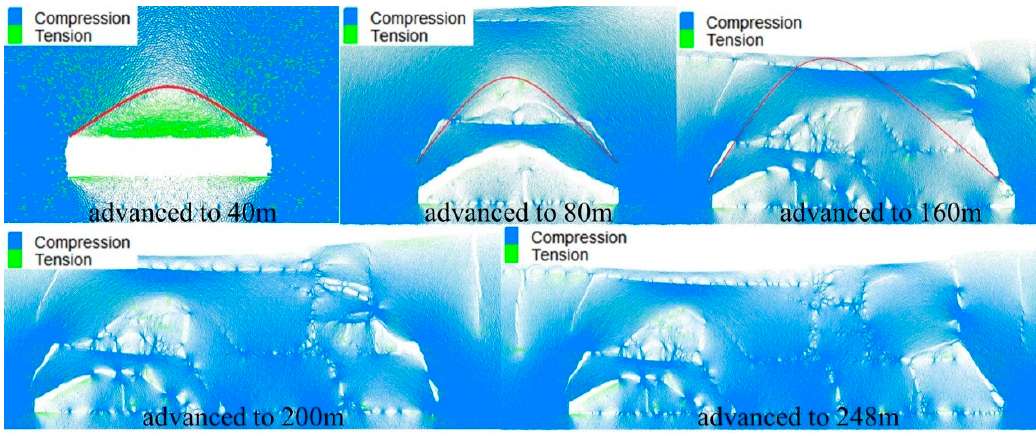
Figure 6. Evolution law of force chains.